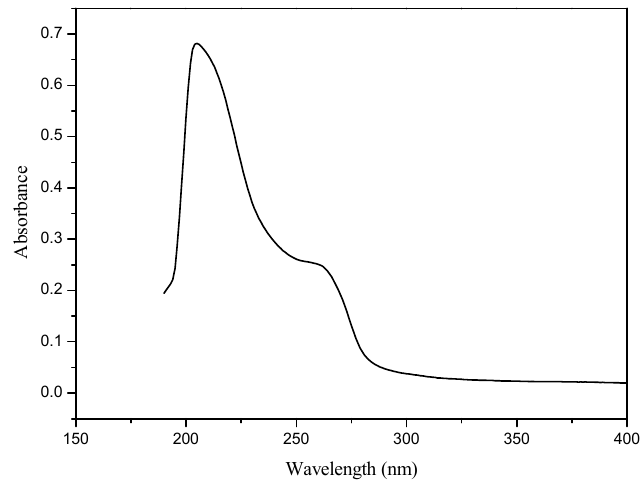
Figure 6. UV-vis spectrum of complex 1 .